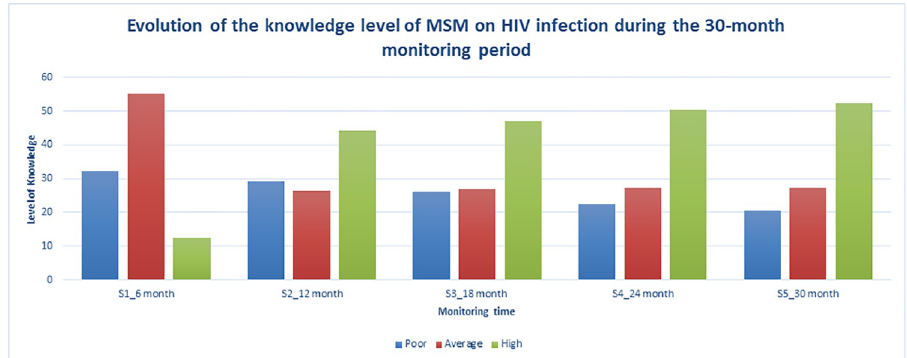
Fig 2. Evolution of the knowledge level of MSM on HIV infection during the 30-month monitoring period, Be´nin 2018.